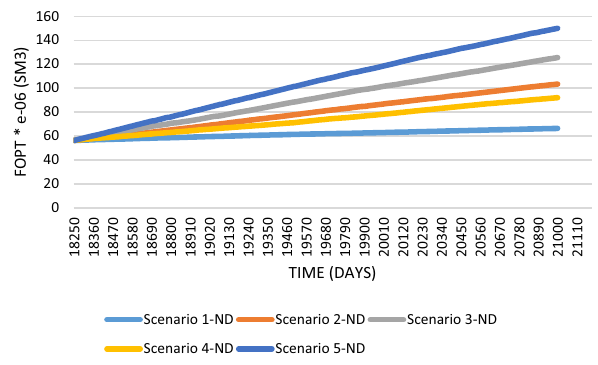
Fig. 5 Cumulative production of gas in five natural depletion scenar- ios